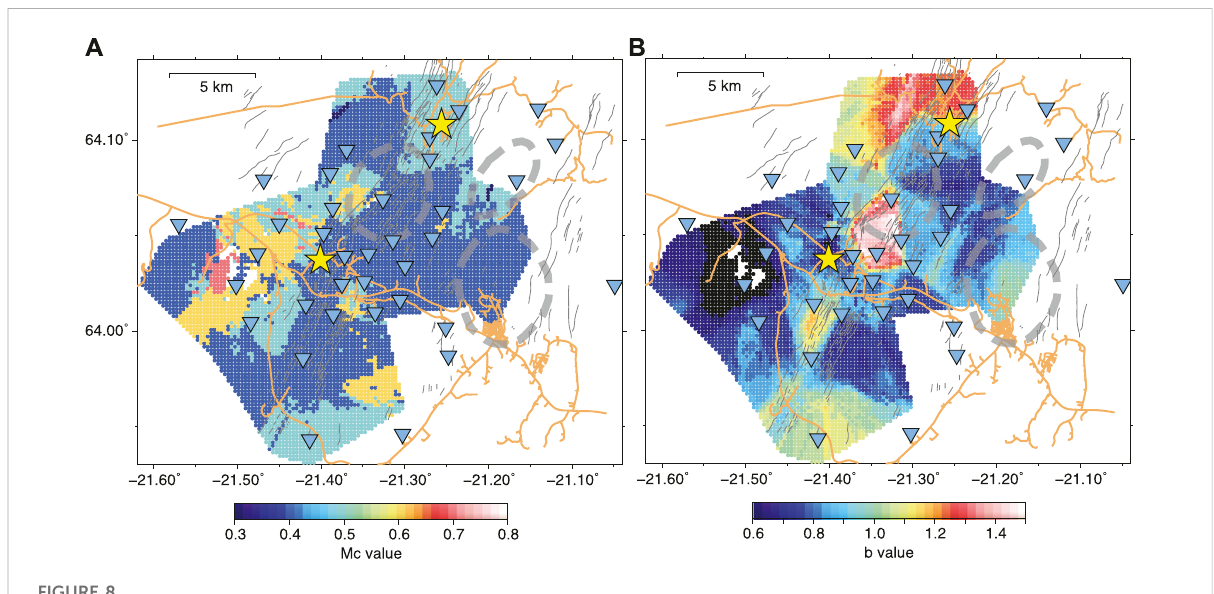
FIGURE 8 Map of the Hengill geothermal area. Color-coded is to the left (A) ; the minimum magnitude of completeness, Mc, estimated from the MQ catalog tonodesofagridspaced0.2 kmapart.Totheright (B) ;b-valuemapusingthesameevents.Roadsareshownasbrownlinesandyellowstars mark the power plants at Hellisheiði (south) and Nesjavellir (north). Gray dotted lines mark the three volcanic centers (Árnason et al.,